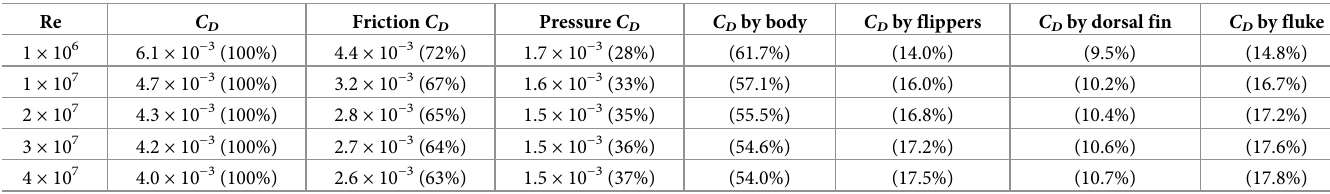
Fig 10. Color contour map visualizing the calculated hydrodynamic forces on the model of white-beaked dolphin ( Re = 2 × 10 7 , U = 10.2 m s -1 ). ( A ) Pressure. ( B ) Wall shear stress. https://doi.org/10.1371/journal.pone.0210860.g010 Table 2. Calculated drag coefficients of the 3-D realistic model of dolphin and contributions of each part.